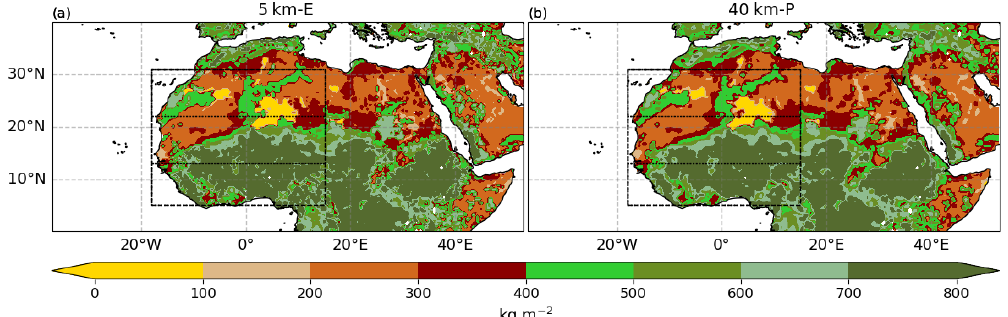
Figure 3. The prescribed constant soil moisture field as a sum over the uppermost six soil layers (up to a depth of 3.42m) in the 5km-E (a) and the 40km-P (b) simulation. The vertical black dashed lines indicate the borders of the coastal, the Sahel, and the Sahara region outlined in Fig. 1.